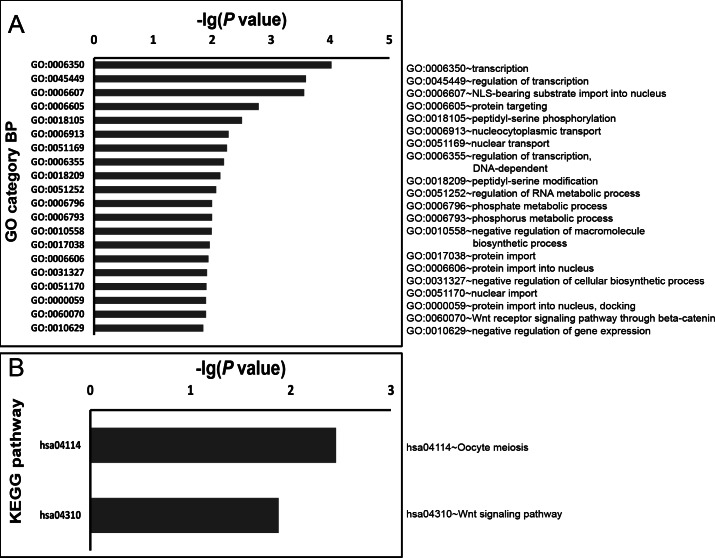
GO biology process and KEGG pathway enrichment analysis for predicted miRNA targets of miR-4668-5p.GO biology process and KEGG pathway enrichments were performed by mapping the predicted target genes using DAVID online analysis tool. P < 0.05 was used as a threshold to select significant GO terms and KEGG pathways. −lg(P value) is the negative log10 of the P value. The top 20 GO biology processes accordign to −lg(P value) and a total of 2 KEGG pathways for miR-4668-5p were annotated. GO, Gene Ontology; BP, biology process; KEGG, Kyoto Encyclopedia of Genes and Genomes.